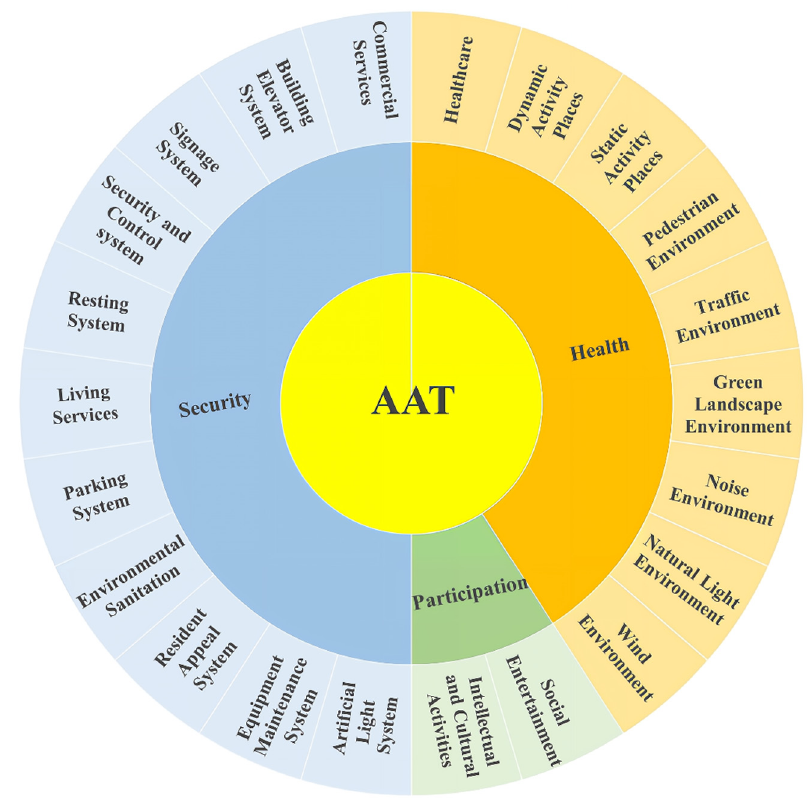
Figure 3. The preliminary classi fi cation of indicators.